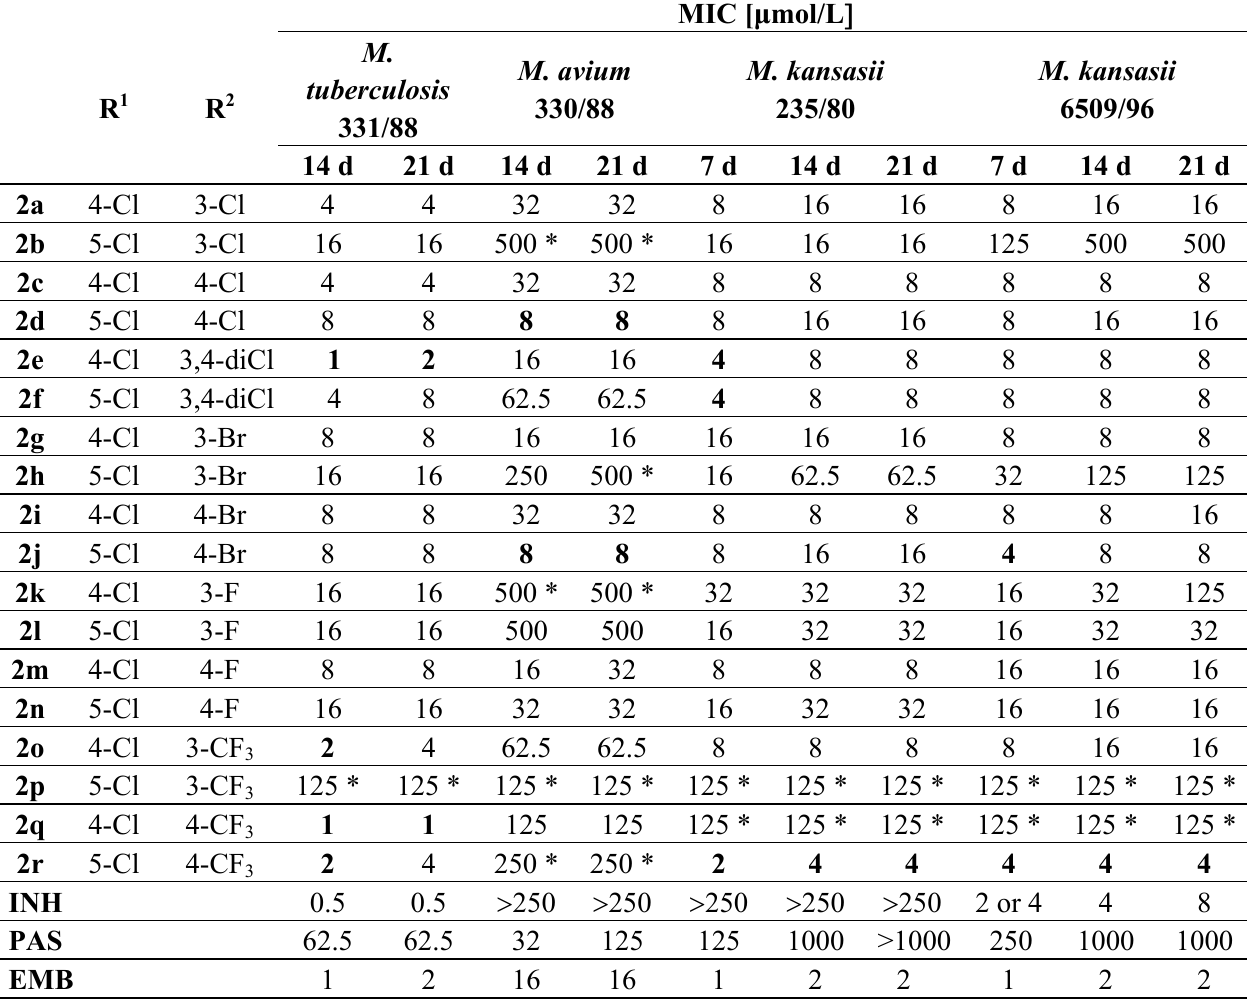
Table 1. Antimycobacterial activity of salicylanilide benzenesulfonates 2